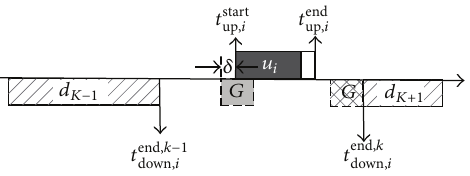
Figure 6: Both start time and end time of the ONU 𝑖 upstream transmission between two downstream transmissions.